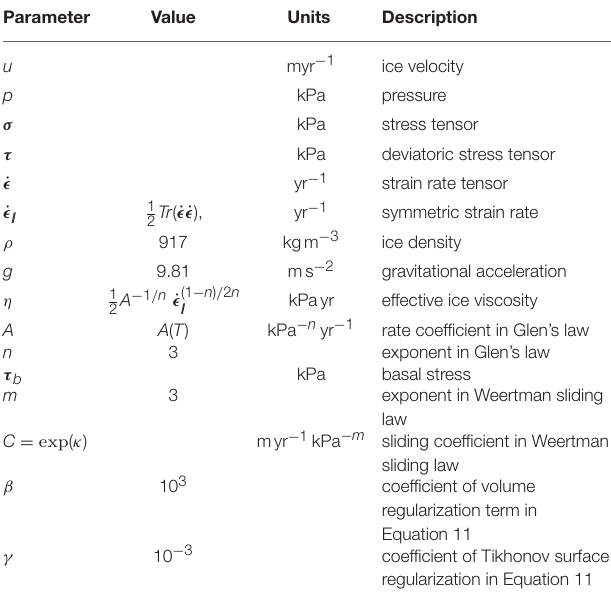
TABLE 1 | List of all variables and